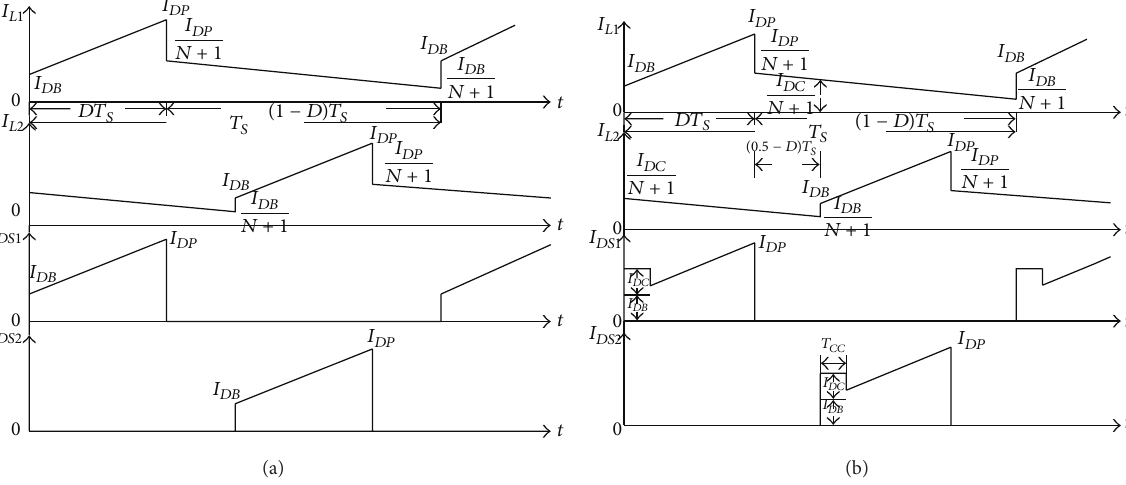
Figure 12: Conceptual current waveforms of switches and inductors in the interleaved boost converter (a) with hard-switching circuit and (b) with single-capacitor